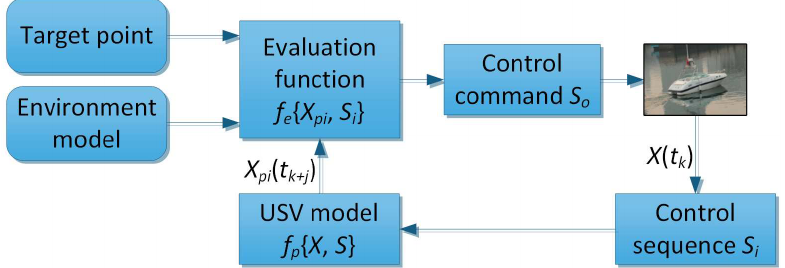
Figure 9. Block diagram of finite control set model predictive control (FCS-MPC) for the collision avoidance subsystem (CAS). USV: unmanned surface